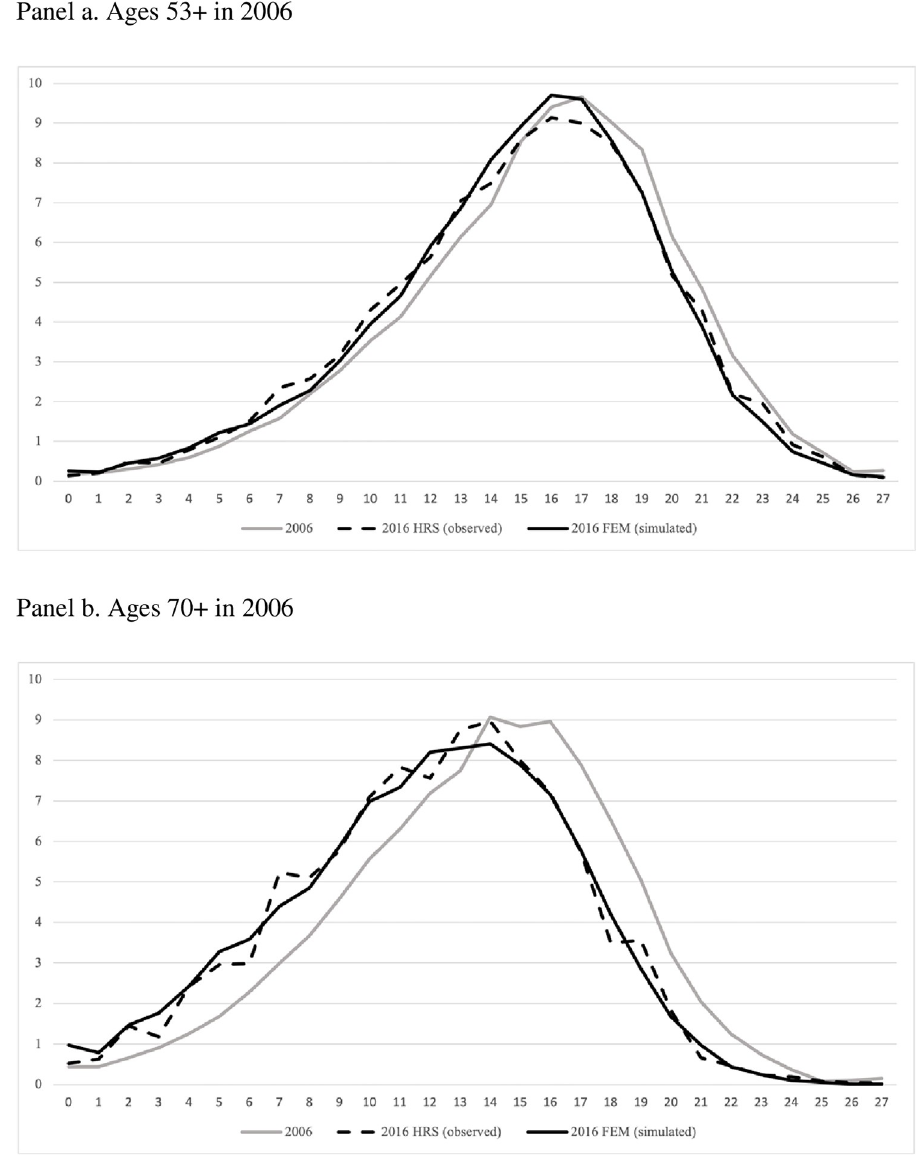
Fig 1. Distribution comparison between HRS and FEM,